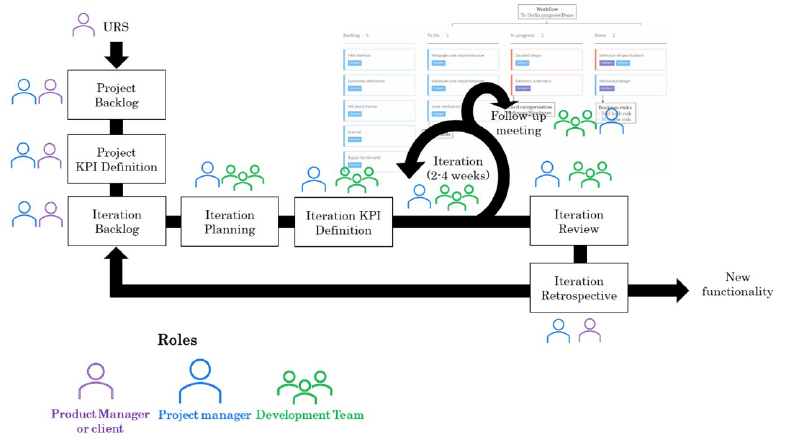
Figure 12. Proposed Agile methodology